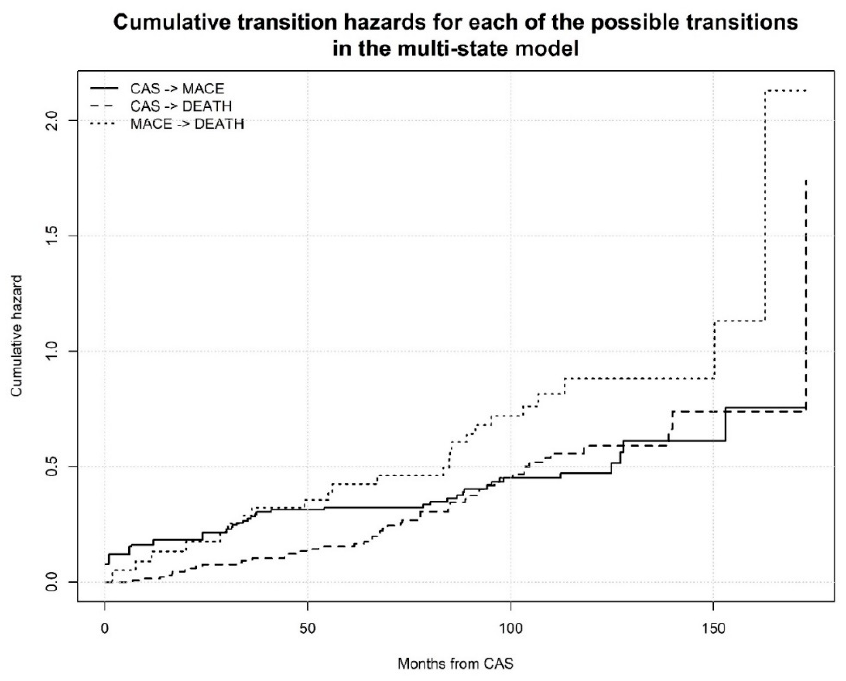
Figure 2. Cumulative transition hazards for each of the possible transition in the multi-state model. Proportional hazards assumption appears clear.